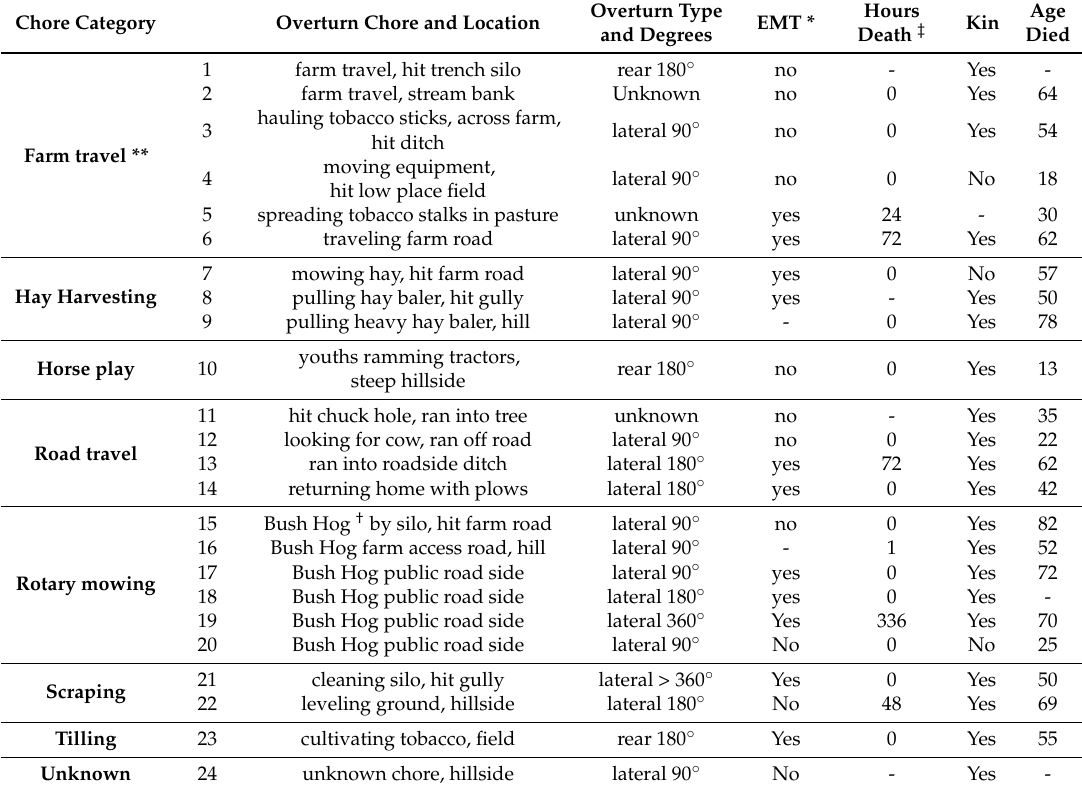
Table 4. Details of fatal non-ROPS tractor overturns by chore category, n = 24.